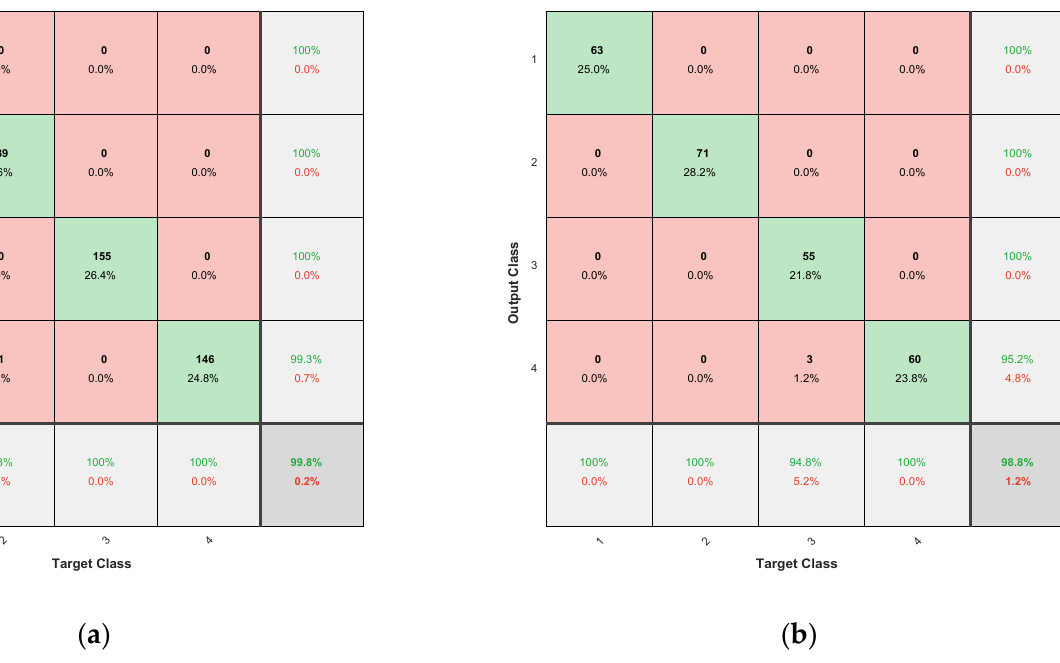
Figure 17. Confusion matrix for training ( a ) and testing ( b ) performance of decision tree. Table 15. Confusion matrix performance.